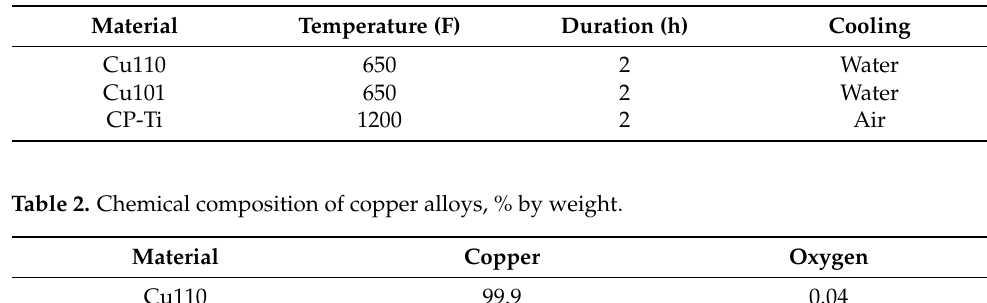
Figure 3. Tensile test results of Cu11 Cu101, and CP-Ti and Johnson-Cook models. Table 1. Heat treatment information of each material.